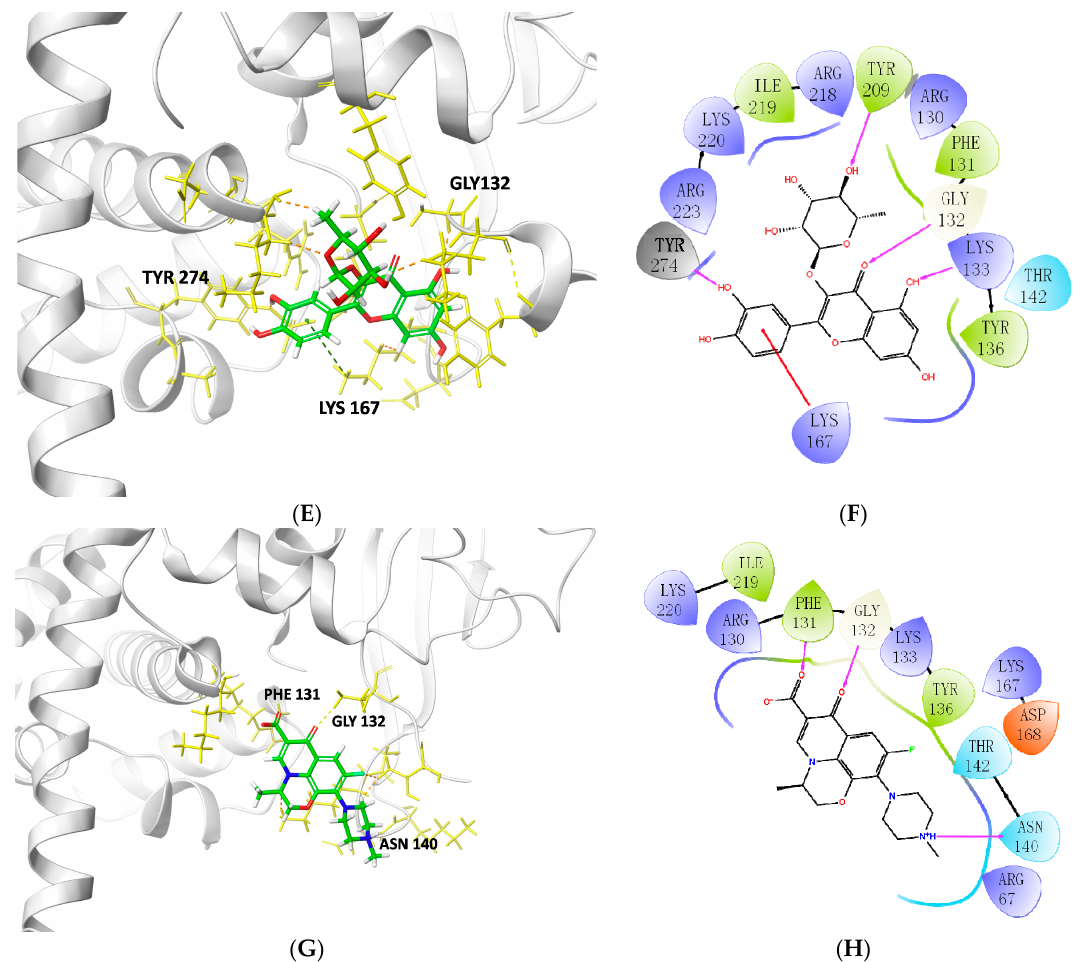
Figure 3. Cartoon on behalf of TOP1 targeted with: ( A , B ) rosmarinic acid; ( C , D ) myricitrin; ( E , F ) quercitrin; ( G , H ) ofloxacin. The 3D combining site was revealed as a cartoon representation, as well as the compounds, shown as sticks. The 2D one was further visualized and signed in the indicated atoms with the interaction force, including the hydrogen bond and hydrophobic contact. Table 2. The MM_PBSA and hydrogen/hydrophobic bonds between the selected compounds and TOP1.